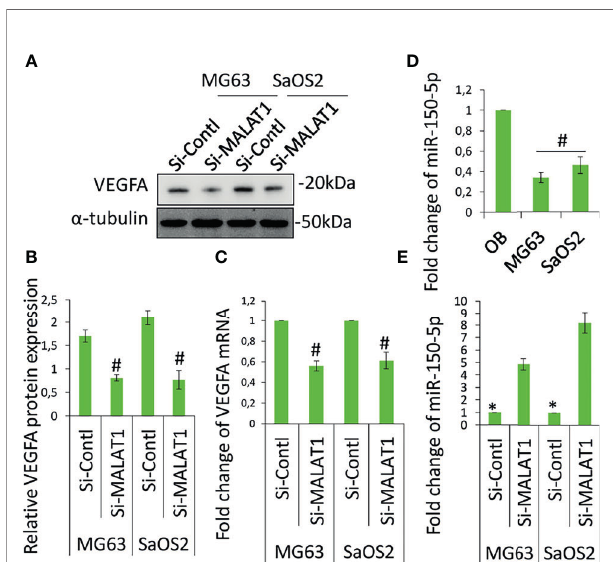
FIGURE 3 | Knockdown of MALAT1 in OS decreased VEGFA and increased miR-150-5p expression. VGFA and miR-150-5p expression was analyzed in MG63 and SaOS2 cells after transfection of si-MALAT1 or si-control. After 24 h, VEGFA protein was analyzed by Western blot analysis (A) . (B) The medium was collected and secreted VEGFA level was analyzed by ELISA kit. Similarly, (C) VEGFA mRNA expression was analyzed by real-time RT-PCR. (D) miR-150- 5p expression was analyzed by real-time RT-PCR in OS cell lines and compared with normal osteoblast differentiated from hDPSCs. (E) After transfection of si- MALAT1 and si-control in MG63 and SaOS2 cells, the expression of miR-150-5p was analyzed by real-time RT-PCR. Asterisk indicates signi fi cant increase compared with si-control, and Number sign indicates signi fi cant decrease compared with